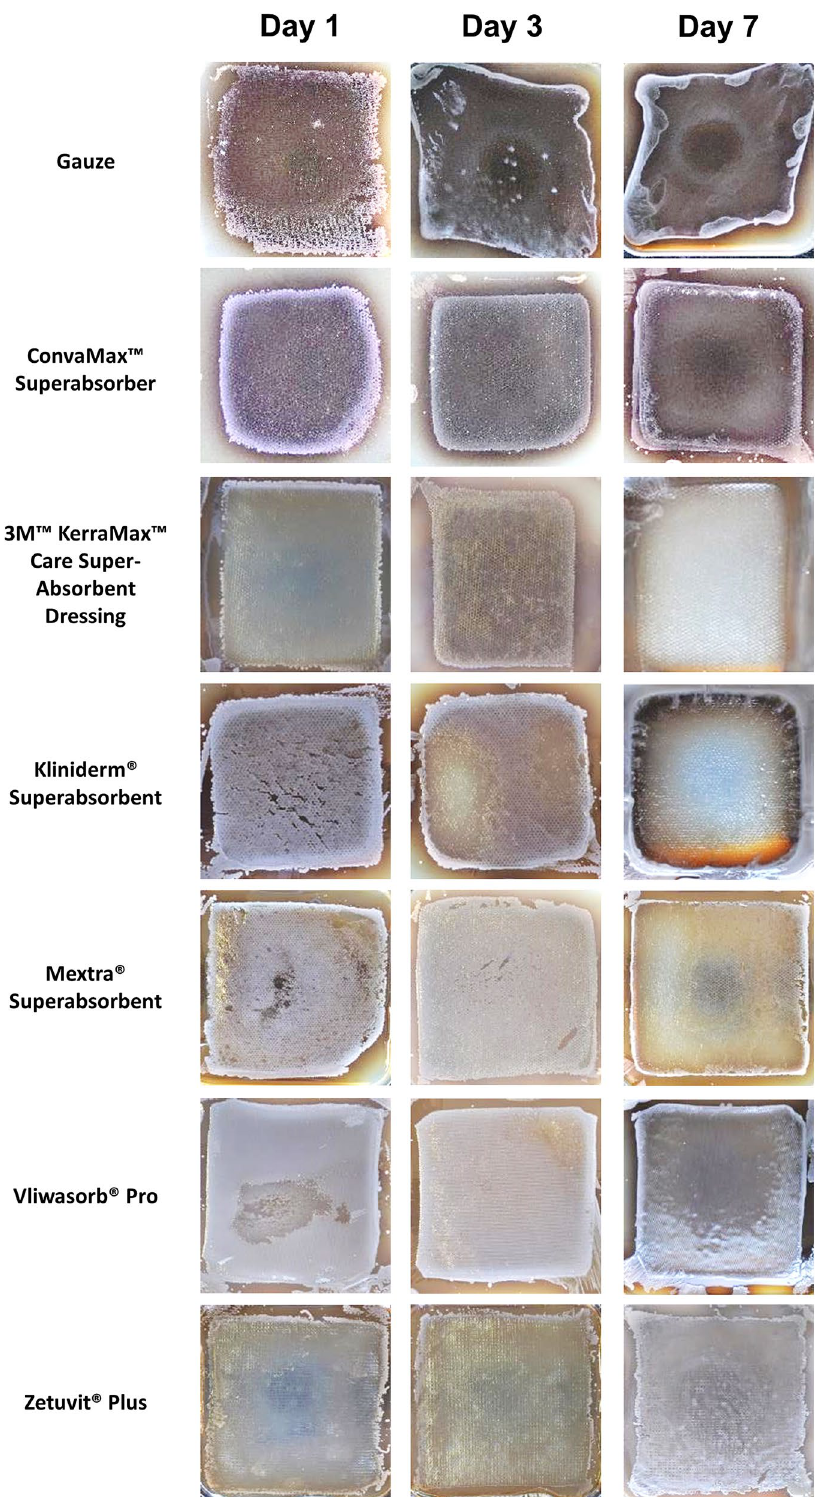
Figure 3. Bacteria transferred to surfaces by superabsorbent dressings. Superabsorbent wound dressings were inoculated with ~ 1 * 10 7 CFU/ml of Pseudomonas aeruginosa daily, over 7 days in triplicate. On 1, 3 and 7 days of inoculation, dressings were transferred to agar and cultured overnight at 37 °C. Dressings were removed and cultured overnight at 37 °C. Plates were imaged for bacterial growth. Representative images for each dressing are displayed. Figure produced in Microsoft PowerPoint